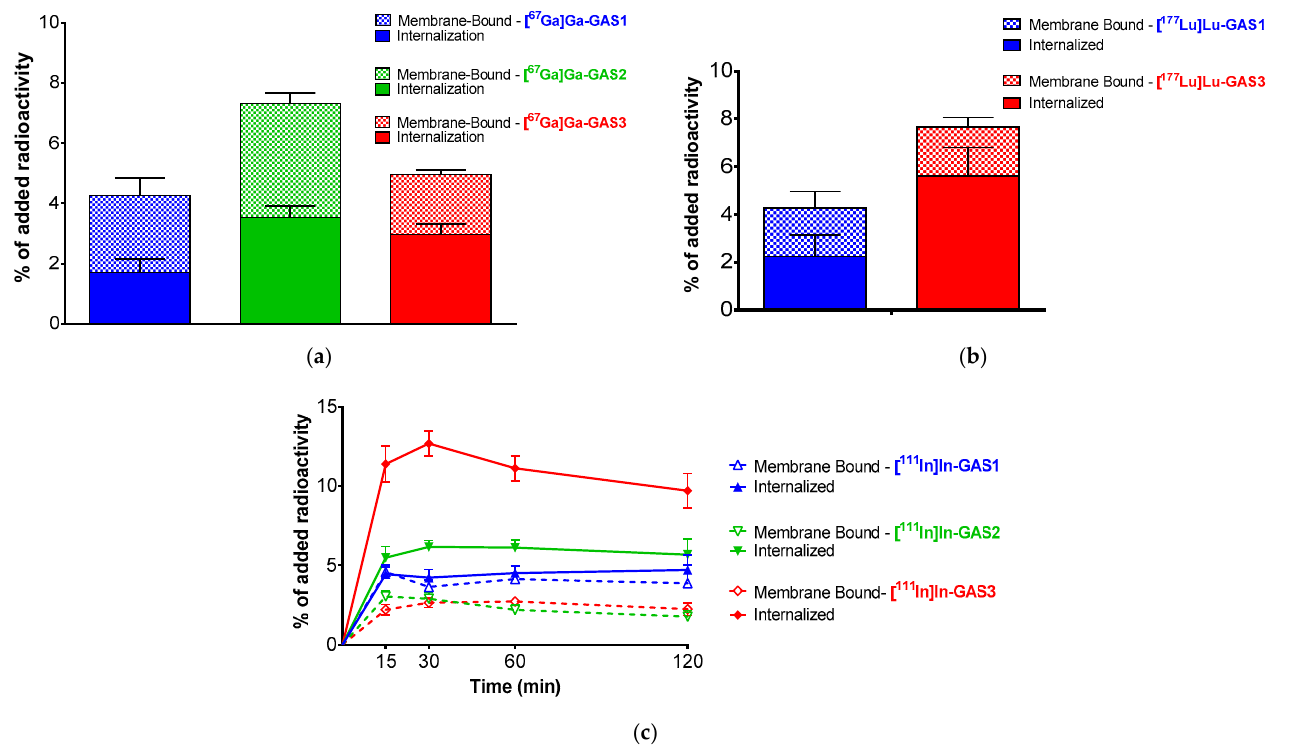
Figure 2. Radioligand uptake-internalization in HEK293-CCK 2i4sv R cells. ( a ) [ 67 Ga]Ga-GAS1/2/3 during 1 h incubation at 37 °C; ( b ) [ 177 Lu]Lu-GAS1/3 during 1 h incubation at 37 °C; ( c ) [ 111 In]In-GAS1/2/3 during 5, 15, 30 min, 1 and 2 h incubation at 37 °C. Solid bars/lines correspond to internalized fractions and chequered bars/lines to membrane-bound fractions. Results represent the average of 3 independent experiments performed in triplicate.